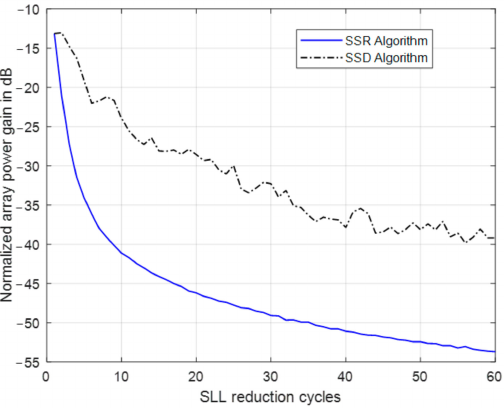
Figure 9. Convergence behavior of the SSD and SSR algorithms with the number of SLL reduction